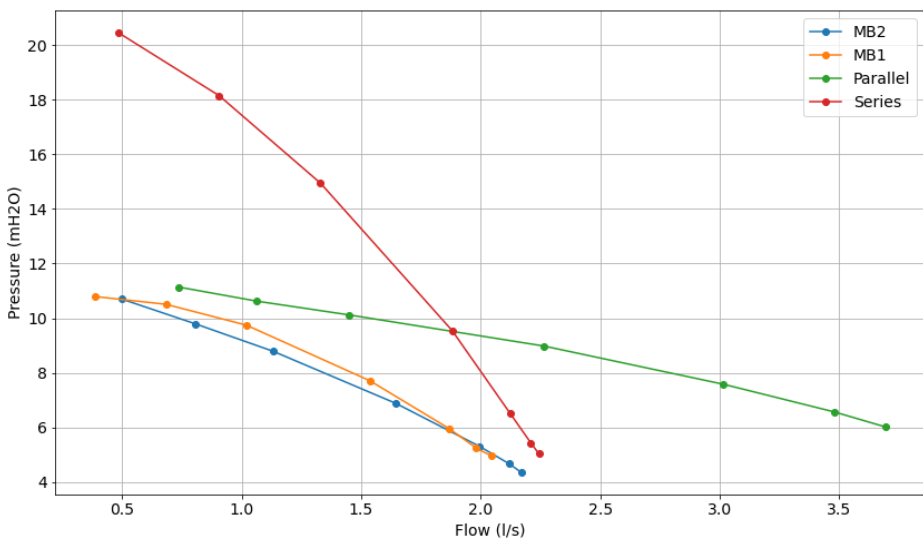
Figure 9. Comparative characteristic curve of pumps operating at 30